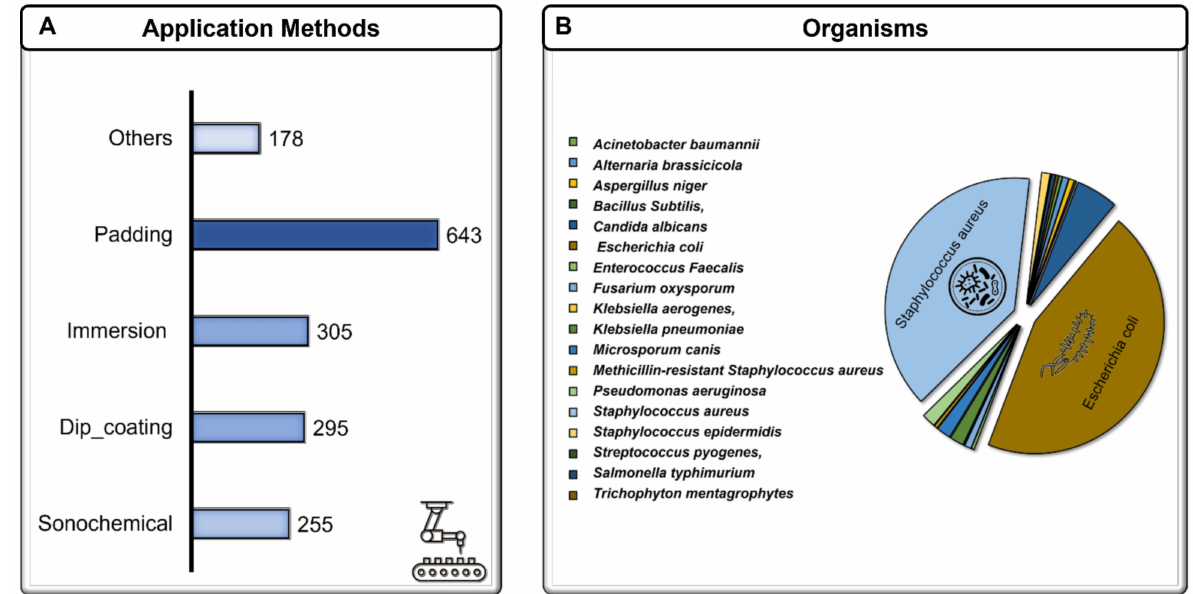
Figure 2. ( A ) Different application methods; ( B ) different investigated organisms (bacteria and fungus) used as input. Numerical values were normalized by three techniques: log10, mean (average) and min-max (Figure 3) and evaluated based on skewness. Normalization by mean had skewness closer to zero for the duration input. Log10 skewness was closer to zero for the primary size and concentration variable.